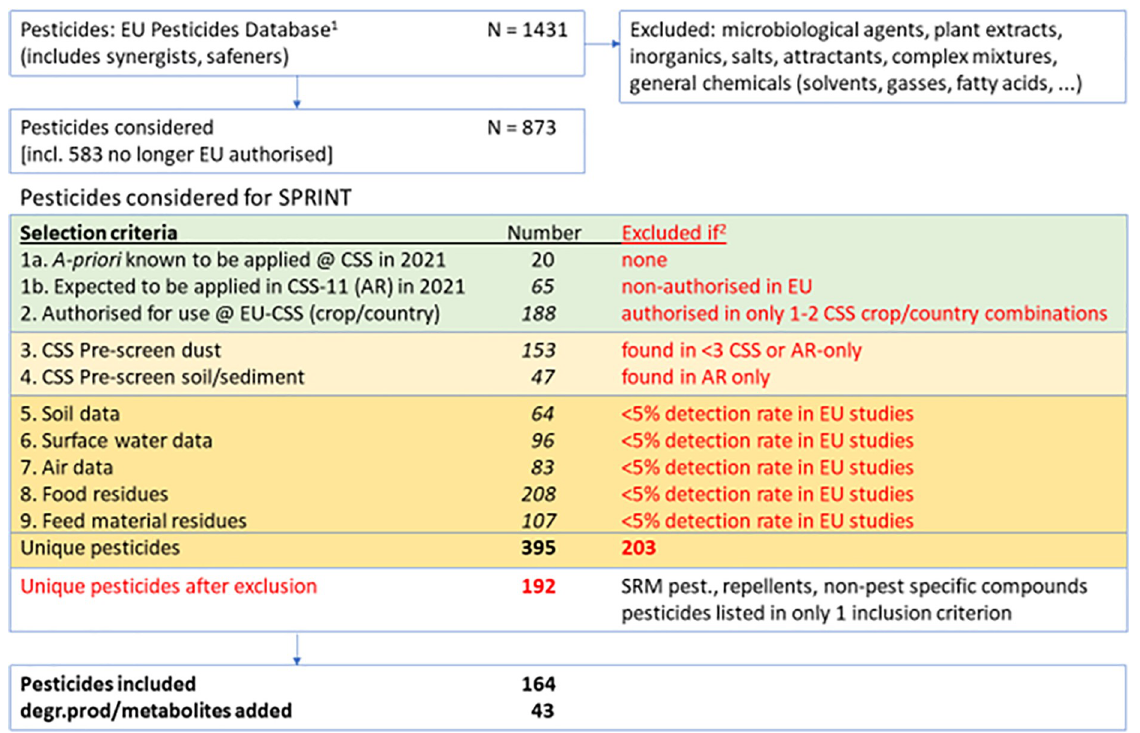
PLOS ONE | https://doi.org/10.1371/journal.pone.0259748 November15,